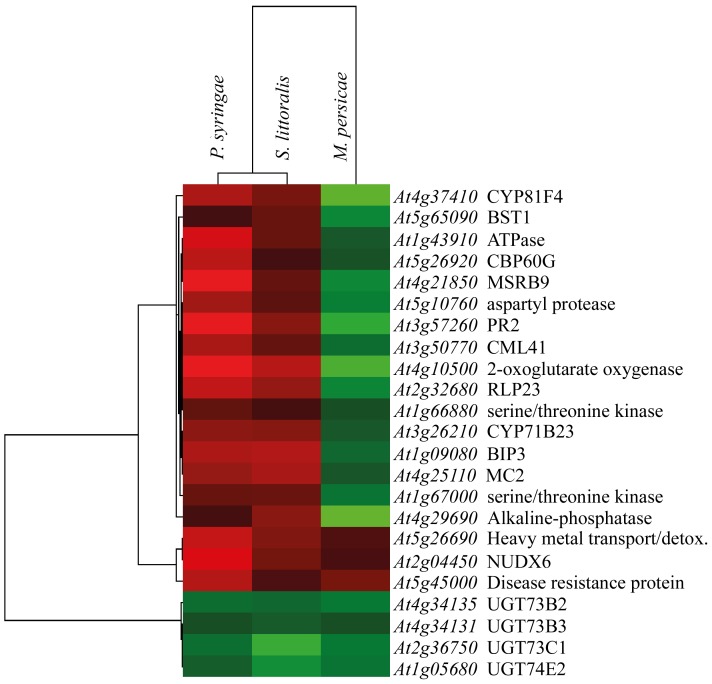
Cluster analysis of commonly regulated genes in Arabidopsis fed by the herbivores Myzus persicae and Spodoptera littoralis and infected by Pseudomonas syringae.
M. persicae shows a lower statistical linkage with S. littoralis and P. syringae, which are linked together.